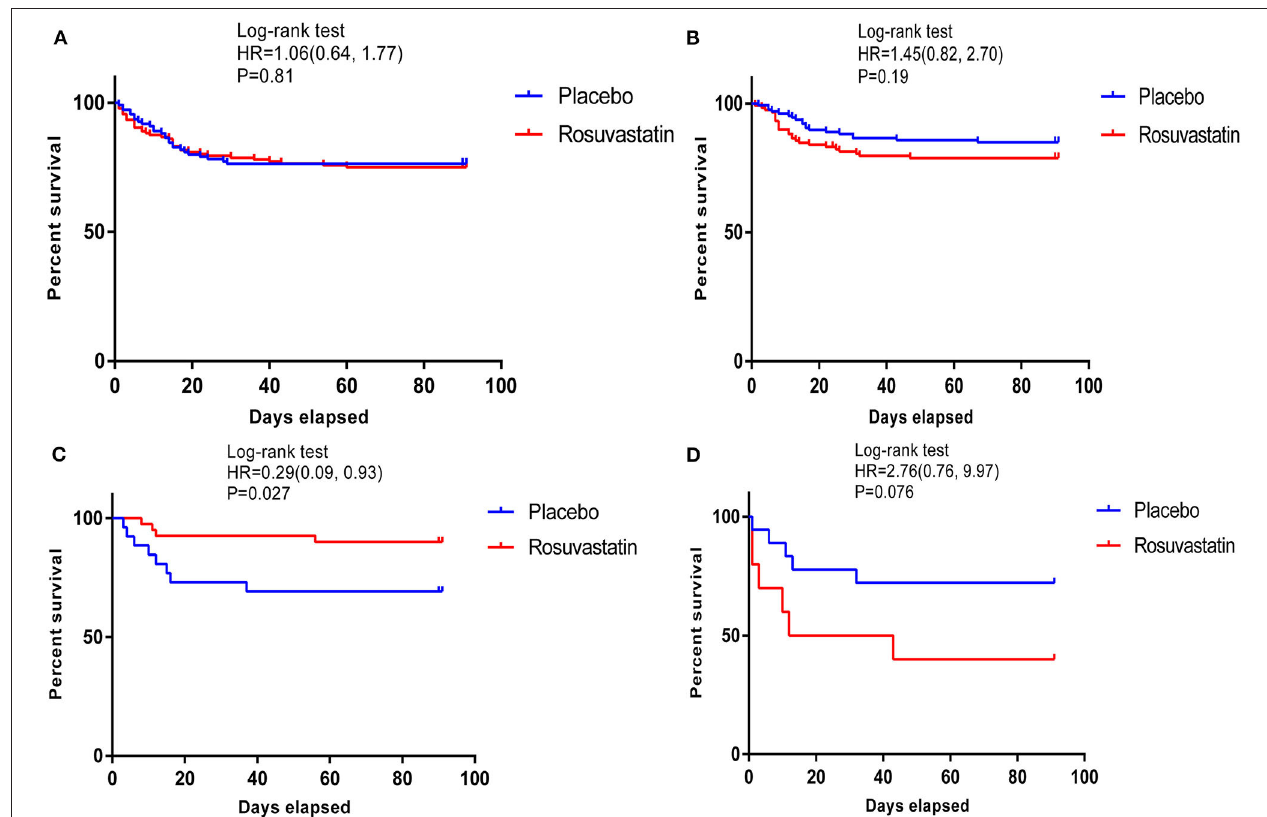
FIGURE 2 | Kaplan–Meier survival curves of 90-day cumulative mortality for patients receiving rosuvastatin and patients receiving placebo among those with the 4 phenotypes. (A–D) shows survival curves of the patients with phenotypes 1–4. In the phenotype 3 cohort, rosuvastatin resulted in a significant reduction in 90-day cumulative mortality [hazard ratio [HR] 0.29 [95% CI 0.09, 0.93]; P = 0.027].